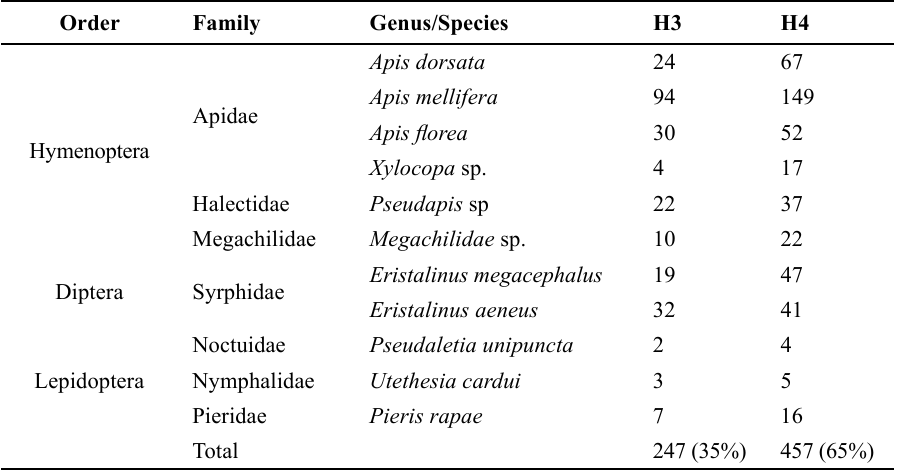
Table 2 . Abundance and diversity of pollinators in bird resistant and susceptible sunflower cultivars.